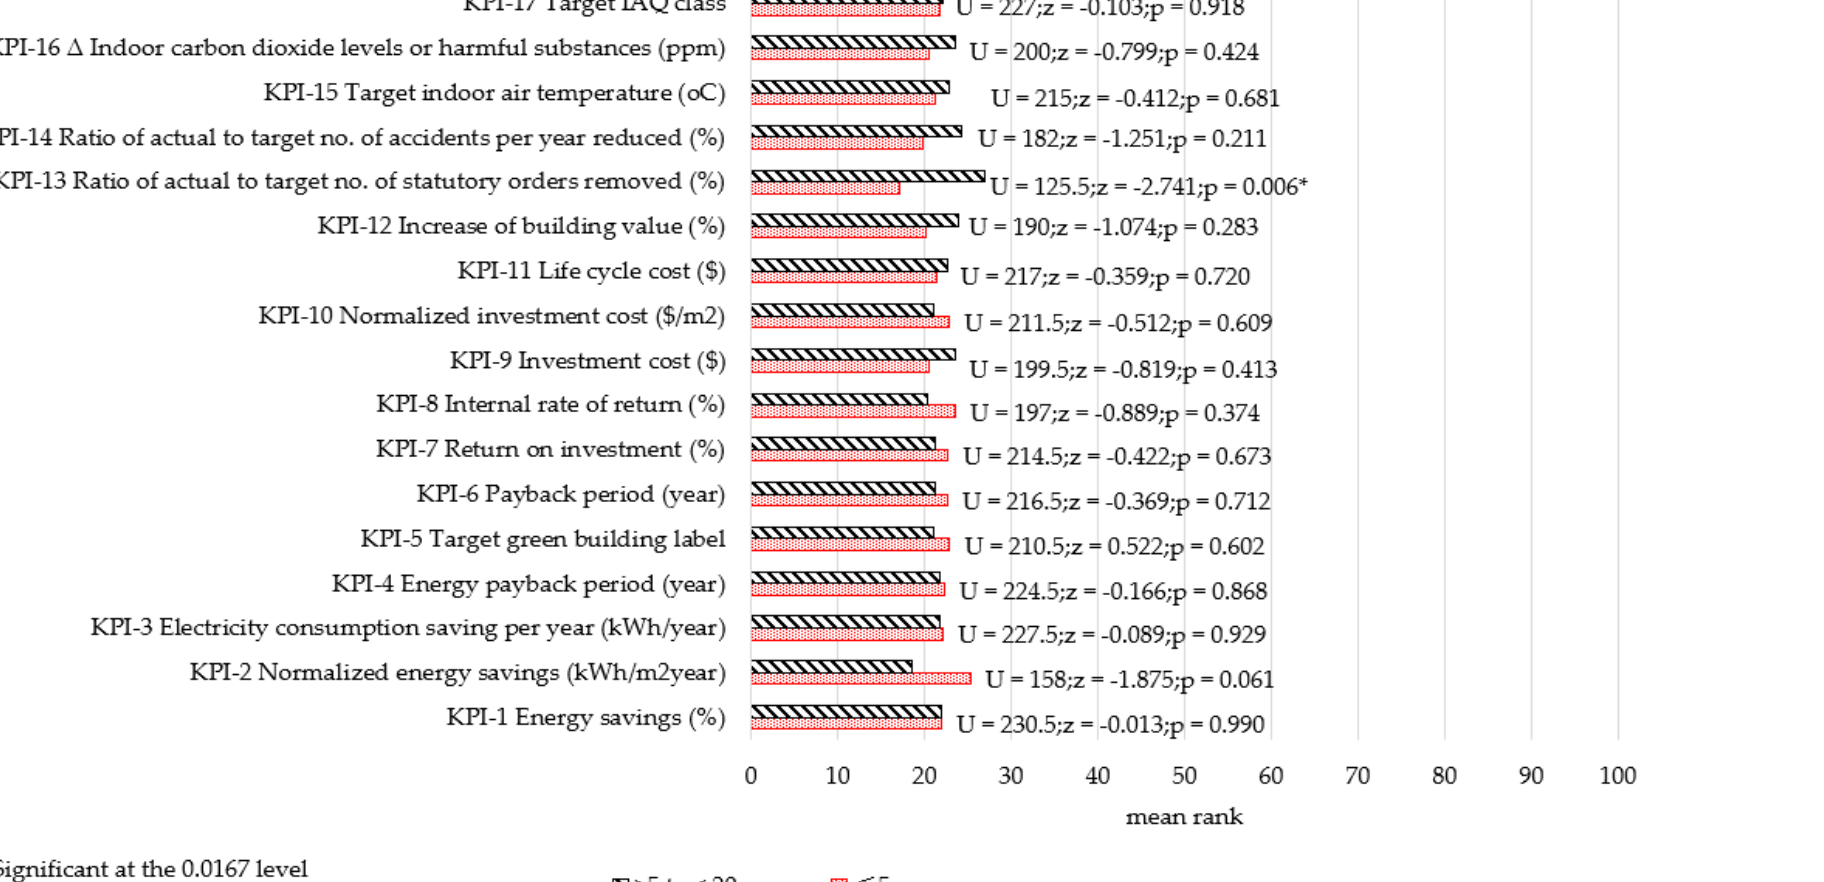
Figure A5. Mann – Whitney U-test results of G2 (work experience: G2a vs. G2b). Figure A5. Mann–Whitney U-test results of G2 (work experience: G2a vs.